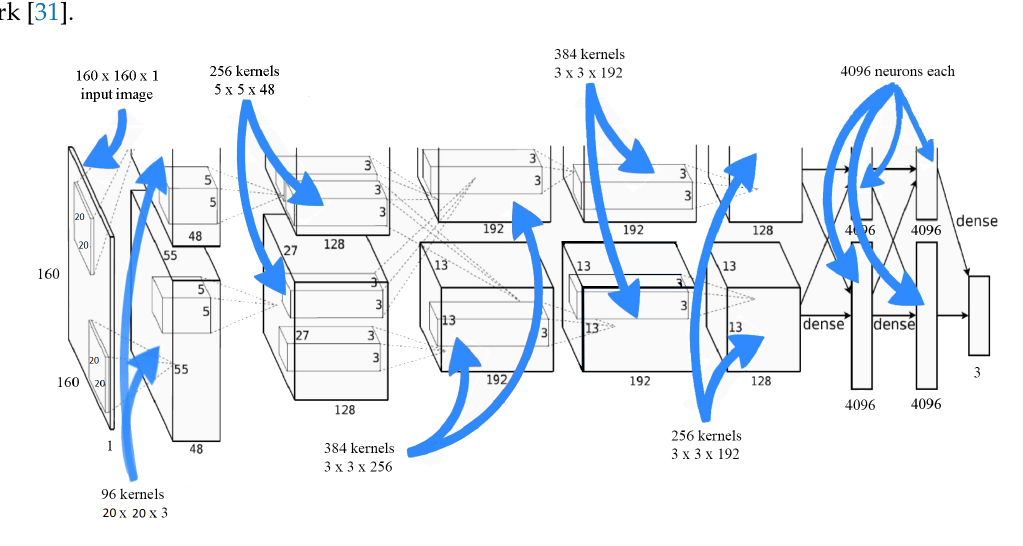
Figure 6. Detailed